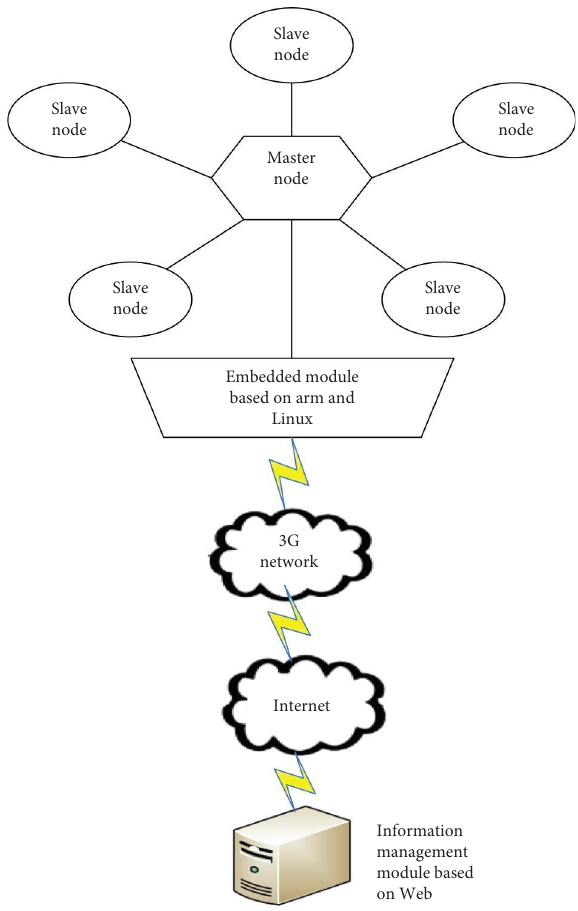
Figure 2: Framework of node data collection model of ecological environment monitoring